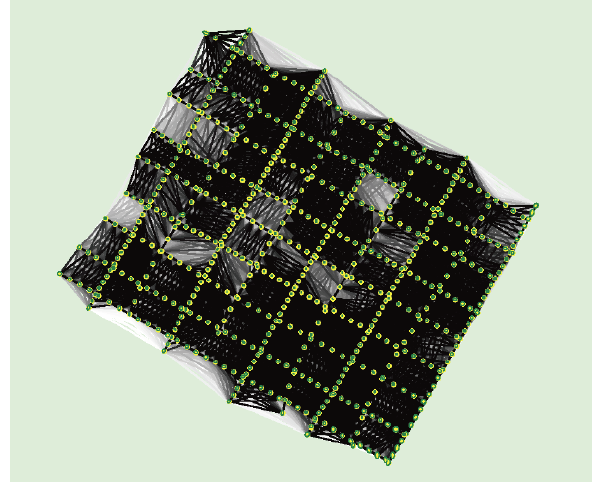
Figure 5. Block configuration